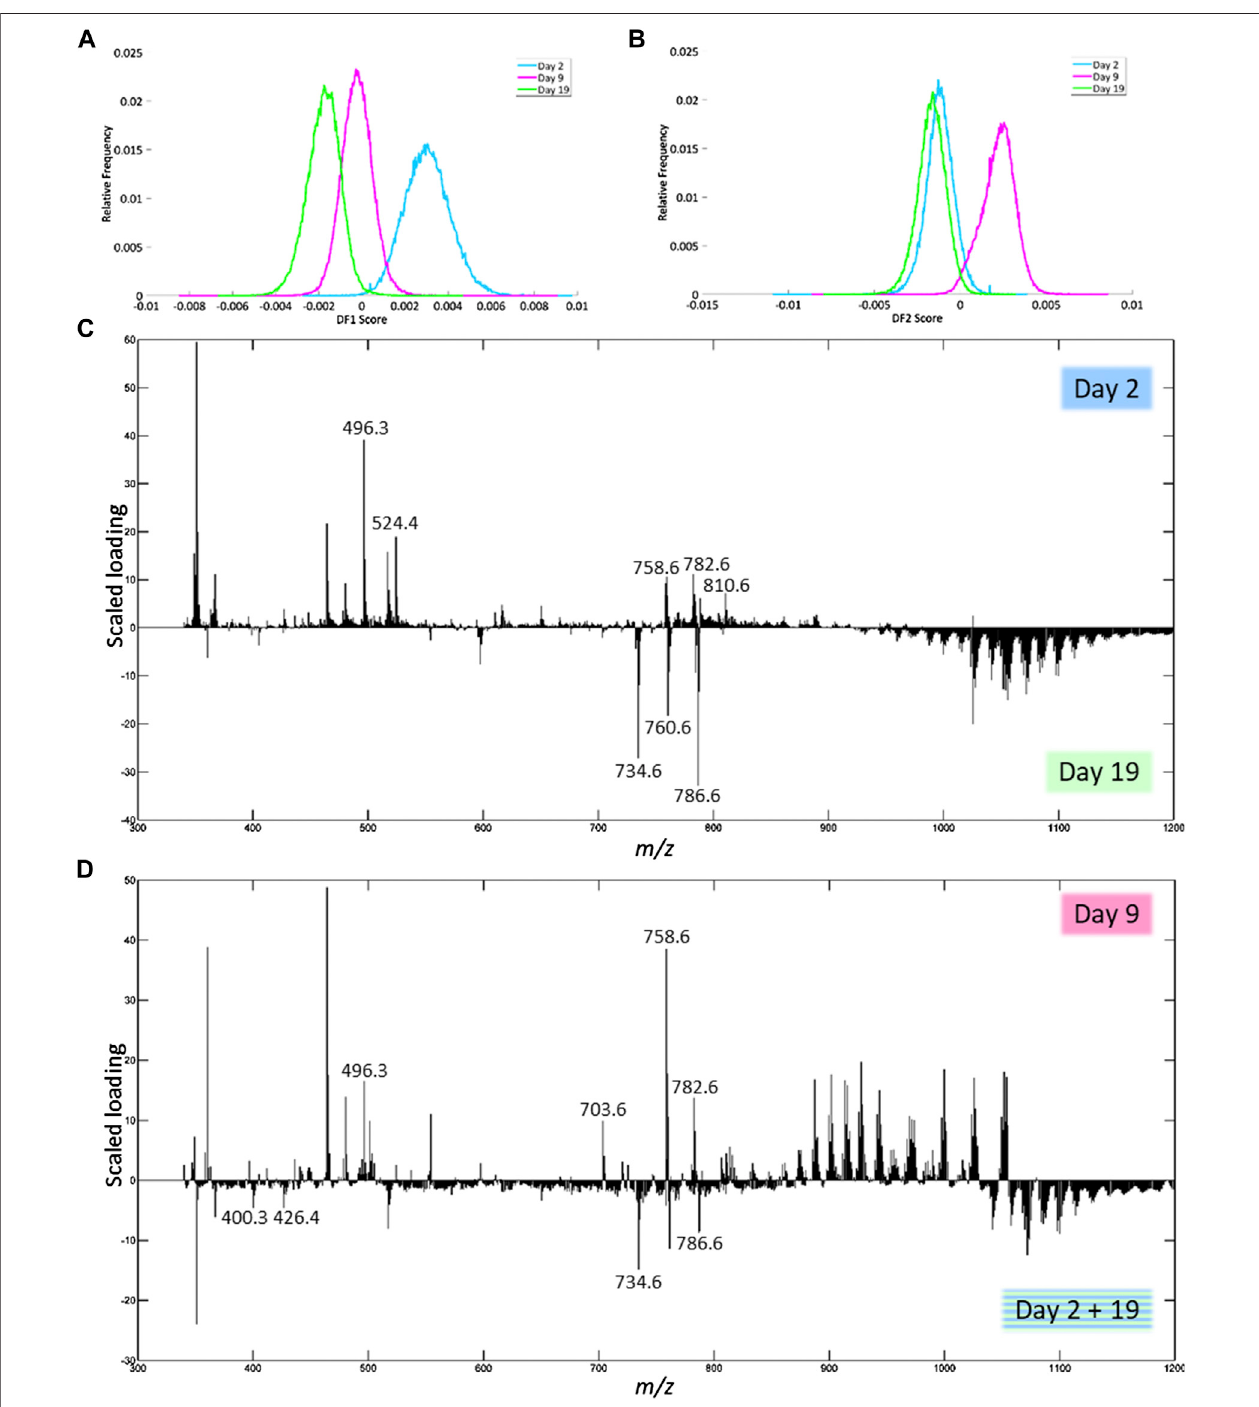
FIGURE 6 | Results of the PCA-LDA of the human fxh of different fxh age (2, 9, and 19 days) for positive ion mode. DF-scores and their corresponding scaled loadingplotsareshown.Thescaledloadingisacombinationoftheintensityofthe m/z valuewithhowmuchthemoleculecontributestotheseparationofclassesacross the speci fi ed discriminantfunction. The positive side for the DF-score plot is related to the positive side of the scaled loading plots. This indicates that the m/z values at a certainsidehaveahighercontributionintheclassatthatside. (A) DF-1scorerepresentingthe fi rstdiscriminantfunction,whichcorrespondstothehighestvariance inthedataset. (B) TheDF-2scorerepresentingtheseconddiscriminantfunction. (C) ScaledloadingplotofthefullmassrangeforDF-1. (D) Scaledloadingplotofthefull mass range for DF-2.